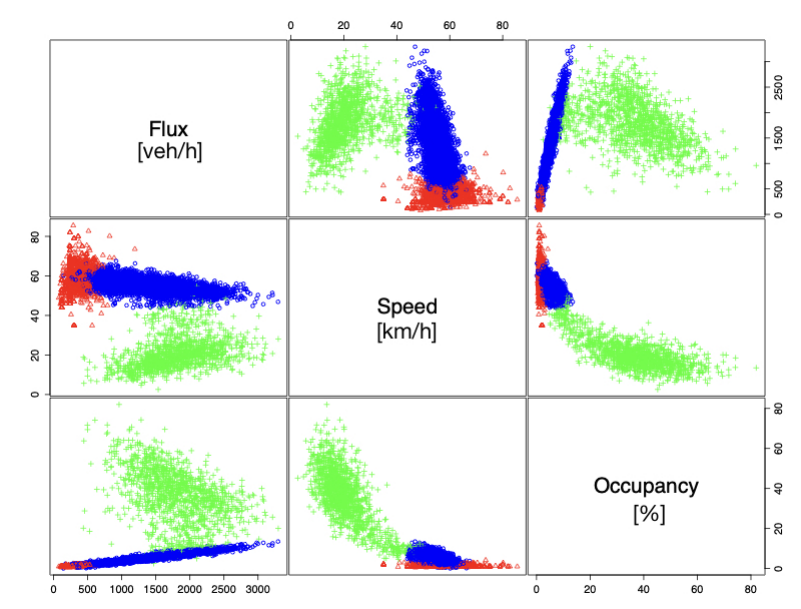
Figure A2. Pairs plot of clustered Rome data. Cluster analyses using the Las Vegas and Sophia Antipolis data corroborate the results obtained with the Rome data. Las Vegas data collected from highway sensors 25 and 99, which we refer to as Nevada 25 and Nevada 99, respectively, clusters into nine phases through ‘mclust’. However, we forced R to choose only two and three clusters to match the original two-phase model of traffic flow proposed by the field and the three-phase model discovered in this study. The results are reported in Figures A3 and A4. The data and analyses suggest that the three-cluster model was preferred using Bayesian information criterion (BIC) for model selection [18].